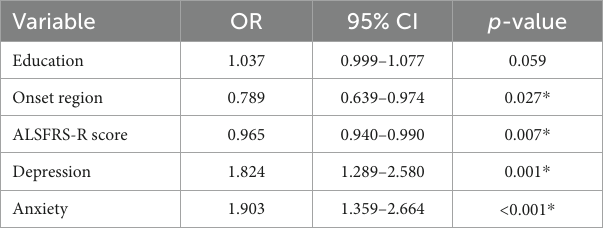
TABLE 4 Logistic regression model analyzed the factors associated with apathy in ALS patients.